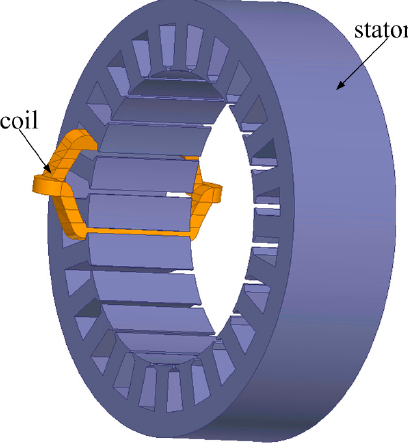
Figure 7. Three-dimensional (3-D) model of one coil for Design A.